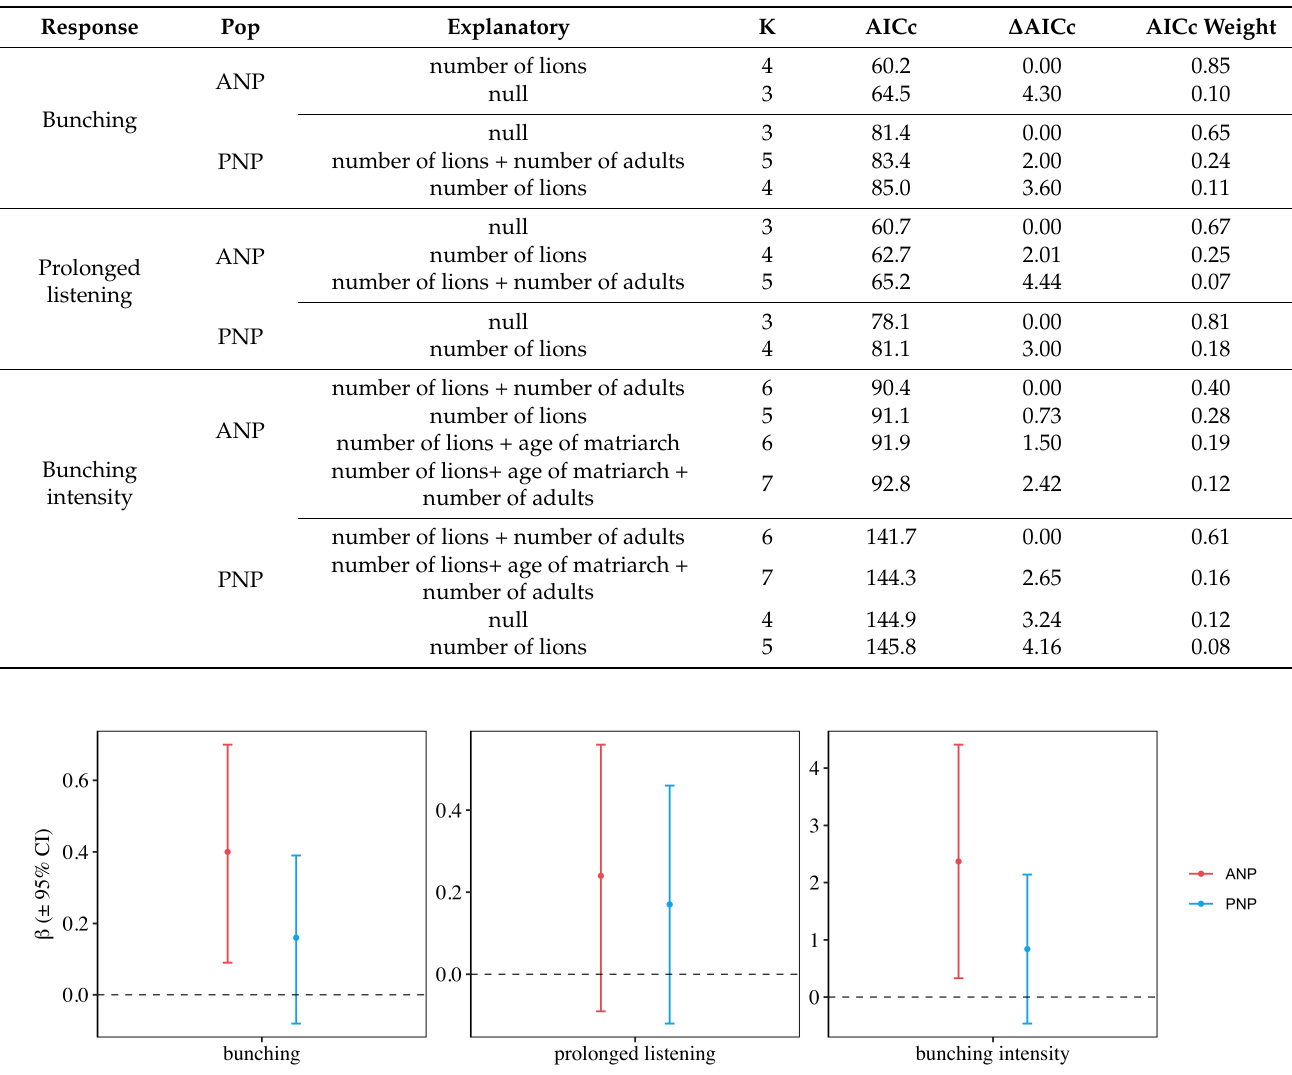
Table 1. Top models accounting for up to ≥ 0.95 AICc weight for bunching, prolonged listening and bunching intensity for the Amboseli (ANP) and Pilanesberg (PNP) populations. K is the parameter count for the model.